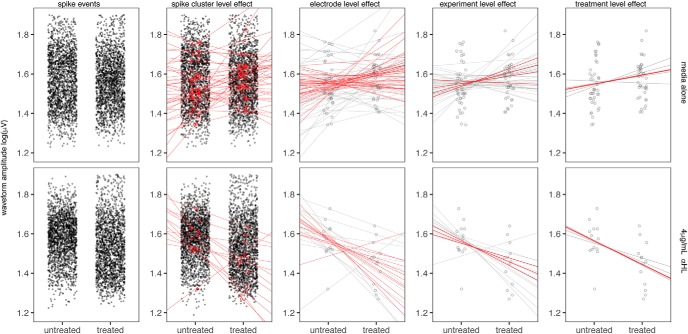
Determining change in wave form amplitude using linear-mixed model. Modeling effect on wave form amplitude in response to treatment media alone (top row) or 4 μg/ml αHL (bottom row) across untreated and treated recordings. Estimates derived from amplitude values of individual waveforms (sample of 2000 shown per condition), and refined at level of spike cluster (open circles), electrodes, experiment, and treatment, indicated above each panel. Estimates at each level shown in red, with estimates of subsidiary level shown in gray.